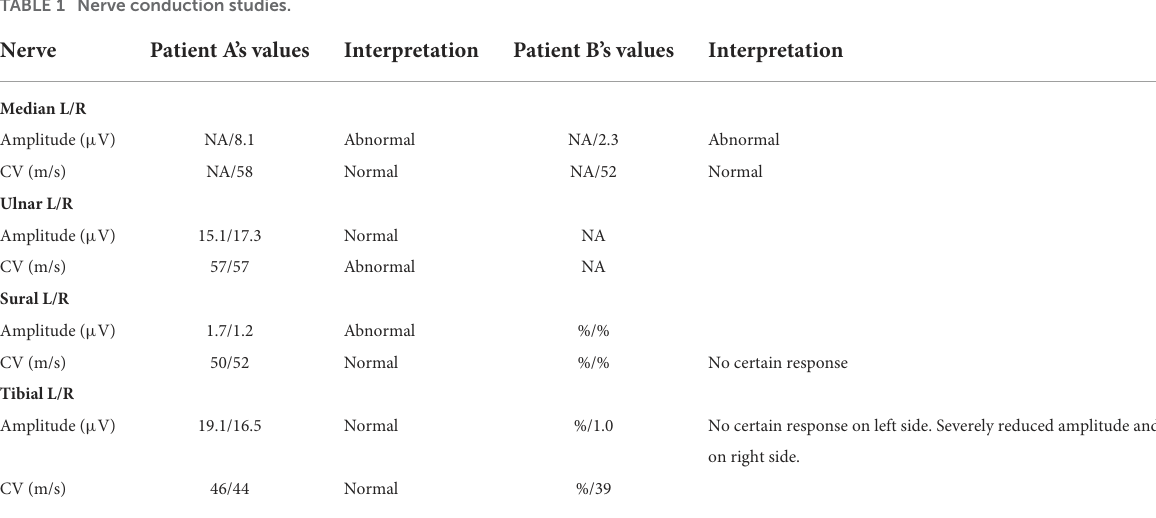
TABLE 1 Nerve conduction